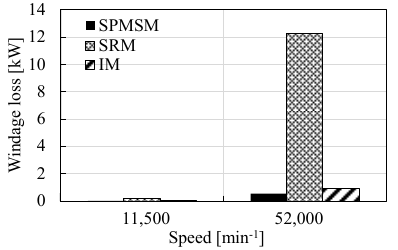
Figure 24. Windage loss.